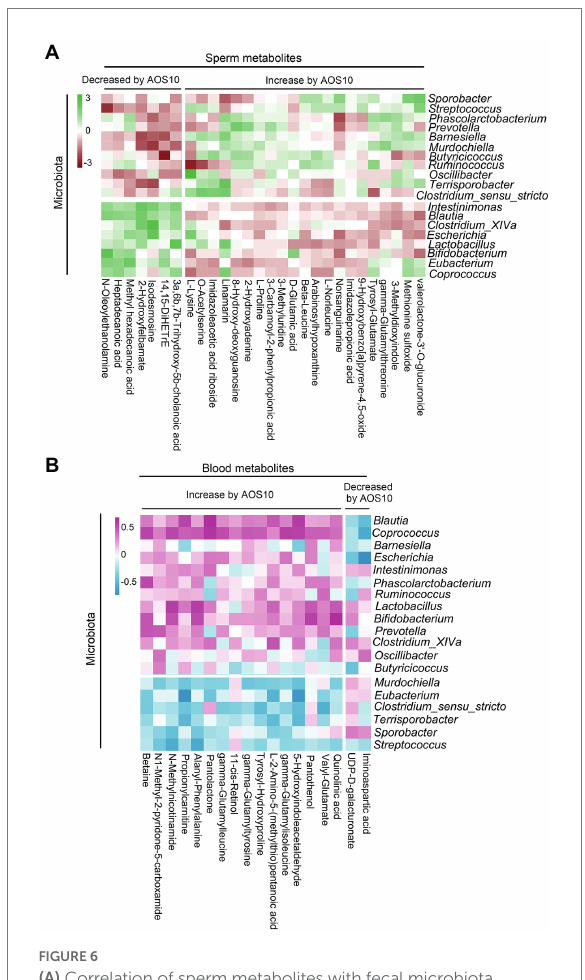
FIGURE 6 (A) Correlation of sperm metabolites with fecal microbiota. (B) Correlation of blood metabolites with fecal microbiota.